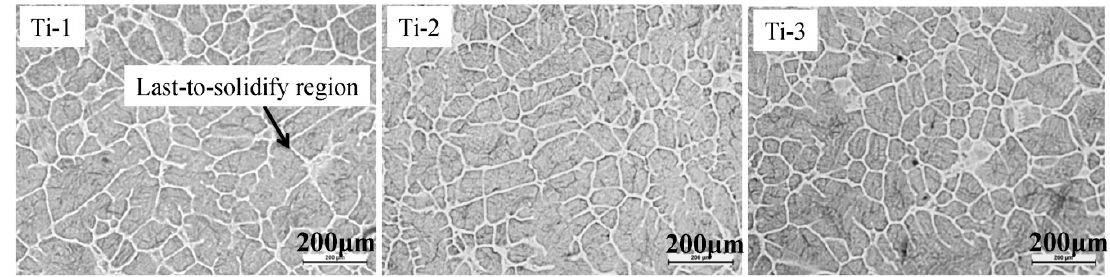
Figure 1. Matrix structure of the Ti-1, Ti-2, and Ti-3 samples.